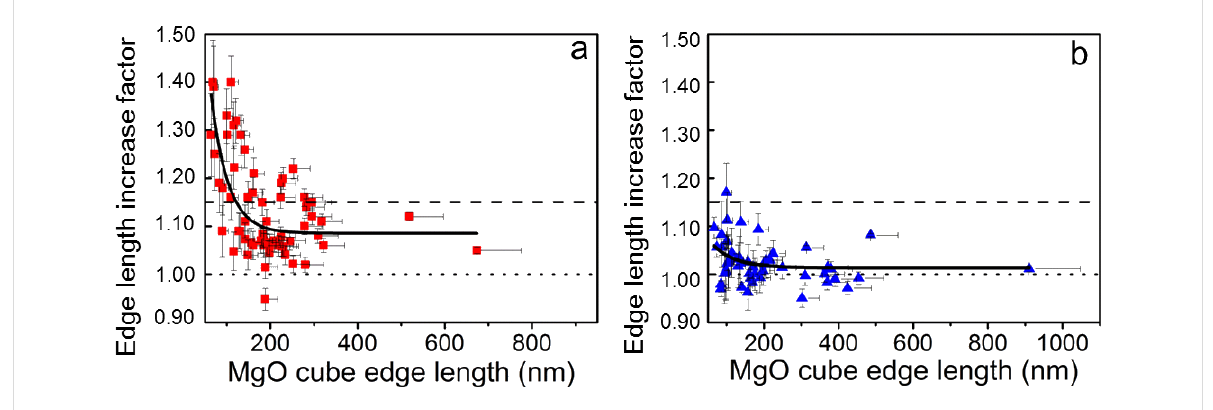
Figure 3: Quantification of morphological changes: Curves showing the edge length increase factor of MgO cubes ( L 2 / L 1 ) as a function of the edge length L 1 , where L 1 and L 2 are the edge lengths before and after storage in the vacuum chamber of the HIM, respectively. (a) The indium foil was used without any further treatment. The dashed line corresponds to a full transformation of MgO into Mg(OH) 2 (i.e., L 2 / L 1 = 1.15). The dotted line cor- responds to zero expansion ( L 2 / L 1 = 1). The y -error bars correspond to the uncertainty caused by the HIM measurement (pixel element size related to magnification and image resolution). The x -error bars correspond to the possible effect of the tilt (maximum 30° tilt, inducing a possible underestima- tion of the edge length of 15%). The continuous black lines (exponential fits) are shown as guides to the eye. (b) The indium foil was dried under vacuum before being used as a